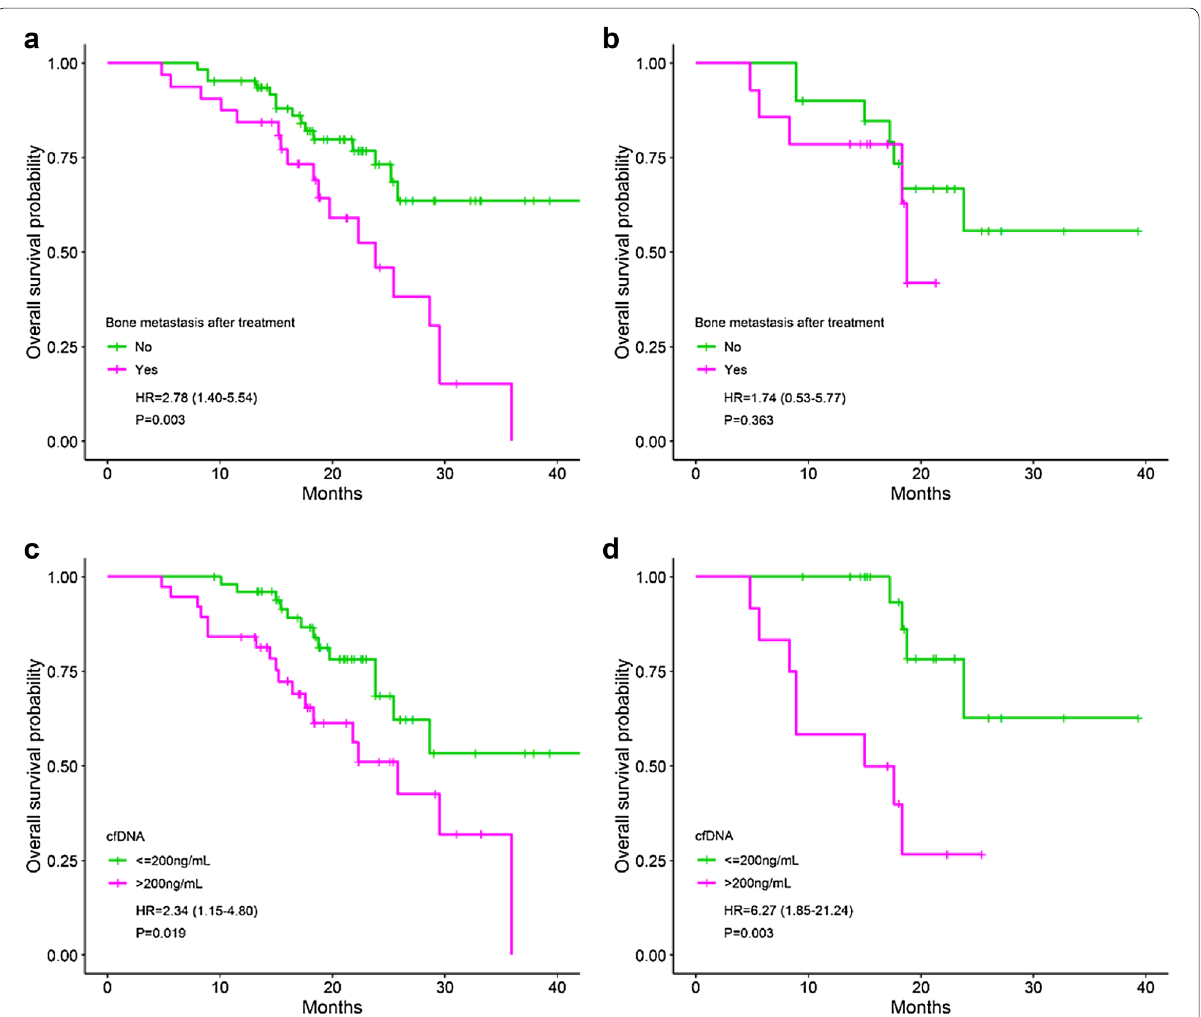
Fig. 7 Overall survival between groups: bone metastasis after treatment ( a £ , b ǂ ); and cfDNA level ( c £ , d ǂ ). £: all patients; ǂ : the newly diagnosed group